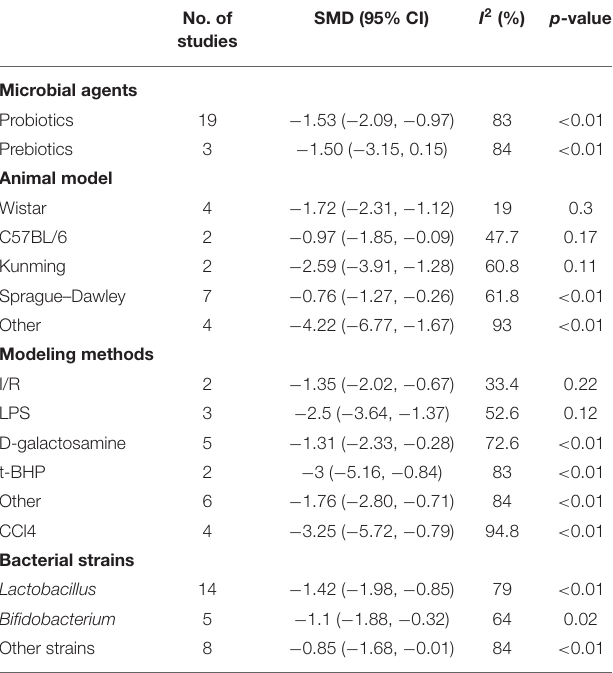
TABLE 2 | Subgroup analysis of